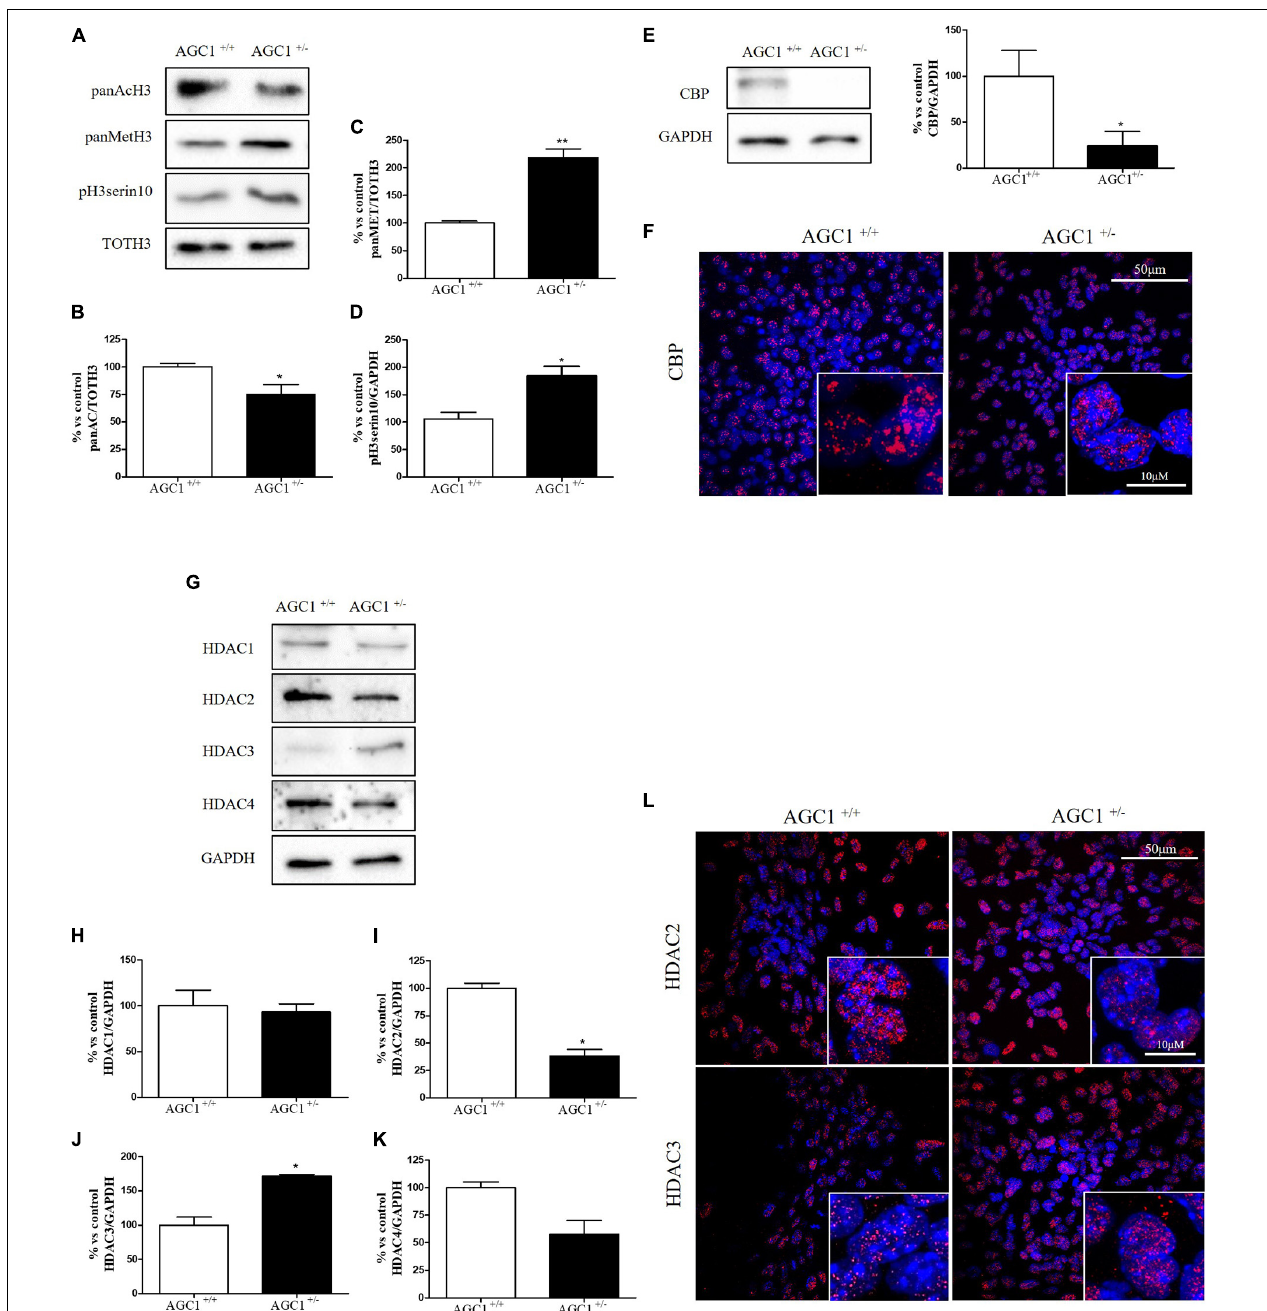
FIGURE 4 | Histone H3 PTMs, HAT, and HDACs expression in AGC1 + / + and AGC1 ± neurospheres. WB analysis and relative densitometries of panAcH3 (A,B) , panMetH3 (A,C) , pH3 (A,D) , CBP (E) , HDAC1 (G,H) , HDAC2 (G,I) , HDAC3 (G,J) , and HDAC4 (G,K) expression in AGC1 ± and AGC1 + / + spontaneously differentiated neurospheres; GAPDH was used for endogenous normalizations. Confocal microscopy images (60X and 100X) of CBP (F) , HDAC2, and HDAC3 (L) in neurospheres; nuclei were labeled with DAPI. 50 and 10 µ m scale bar. Values are mean ± SD of at least 3 independent experiments; ** p < 0.01, * p < 0.05, compared to control; Student’s t